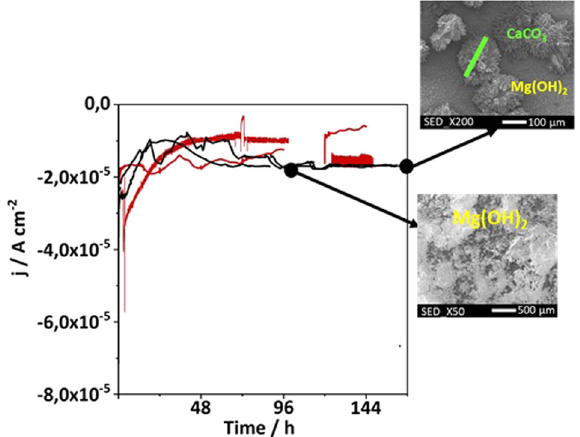
Fig. 7 Monitoring of the current density during 7 days of continuous or interrupted cathodic polarization of DH36 steel immersed in seawater. The "black curve" represents the current density in function of the time for continuous cathodic polarization with the topography of the sample surface after 4 days and 7 days (SEM pictures), and the "red curve" represents the current density in function of the time for interrupted cathodic polarization. Both cases are realized at 20 °C, natural aeration conditions and static conditions.